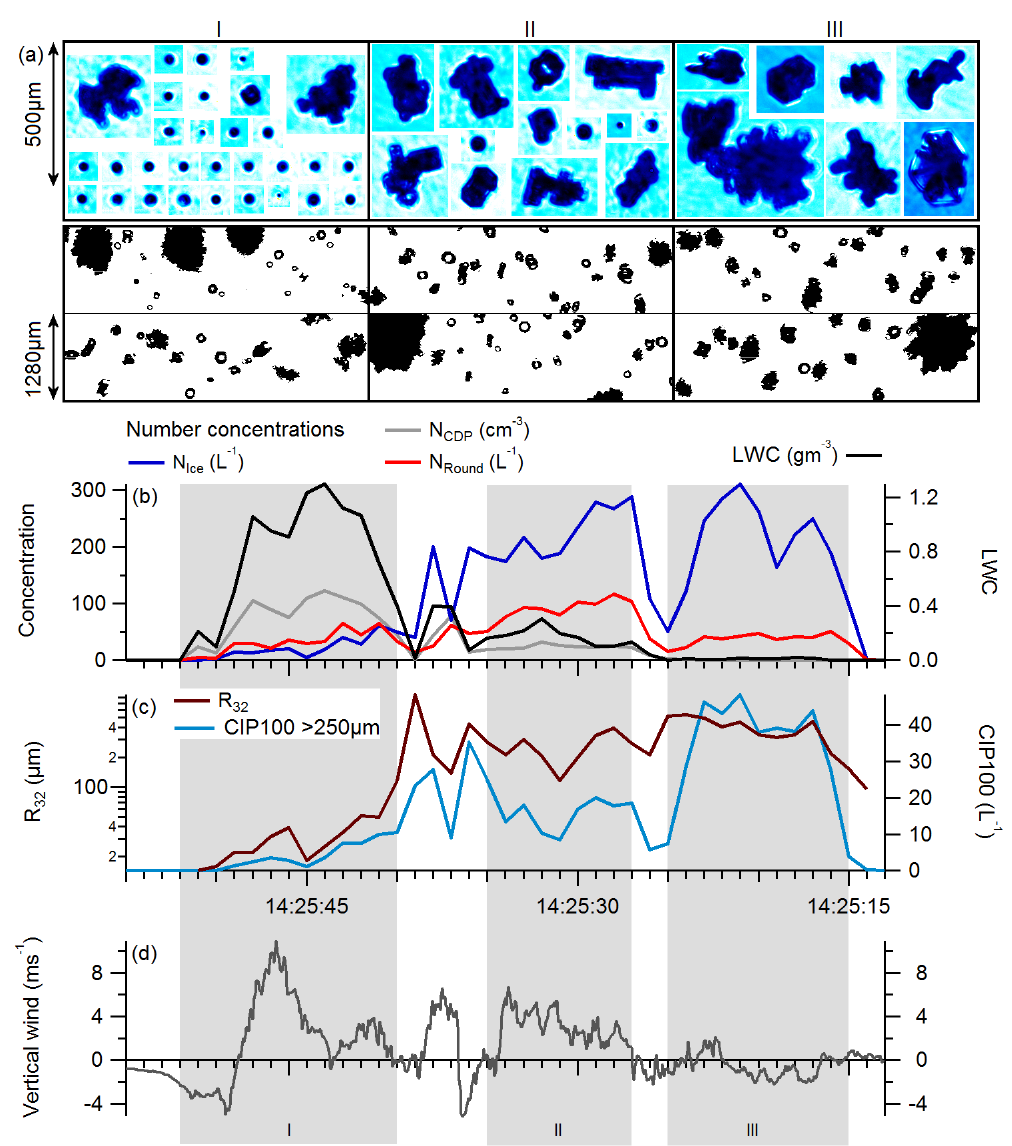
Figure 12. In situ measurements and images recorded by the BAe-146 probes during run 17.3. The time axis runs backwards for clarity in the discussion. The images shown were recorded by the 2DS and CPI probes and are representative images of particles in the sections marked by grey boxes and labelled with Roman numerals. Only images > 50 pixels are shown from the 2DS, and they are not classified by